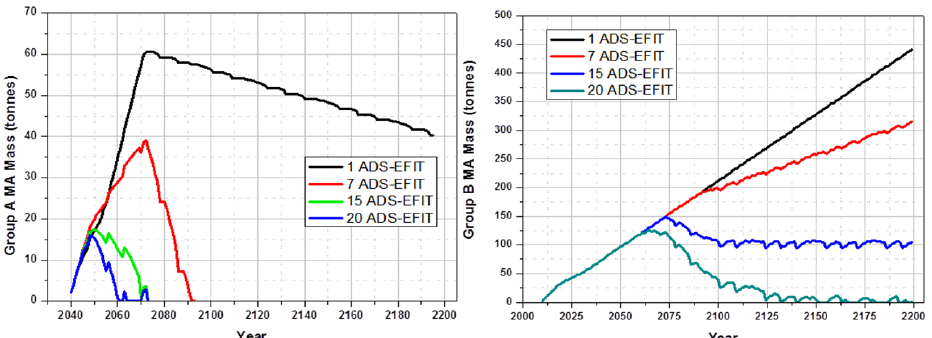
Fig. 3. – Time needed for MA treatment as a function of the number of EFIT units deployed from 2040